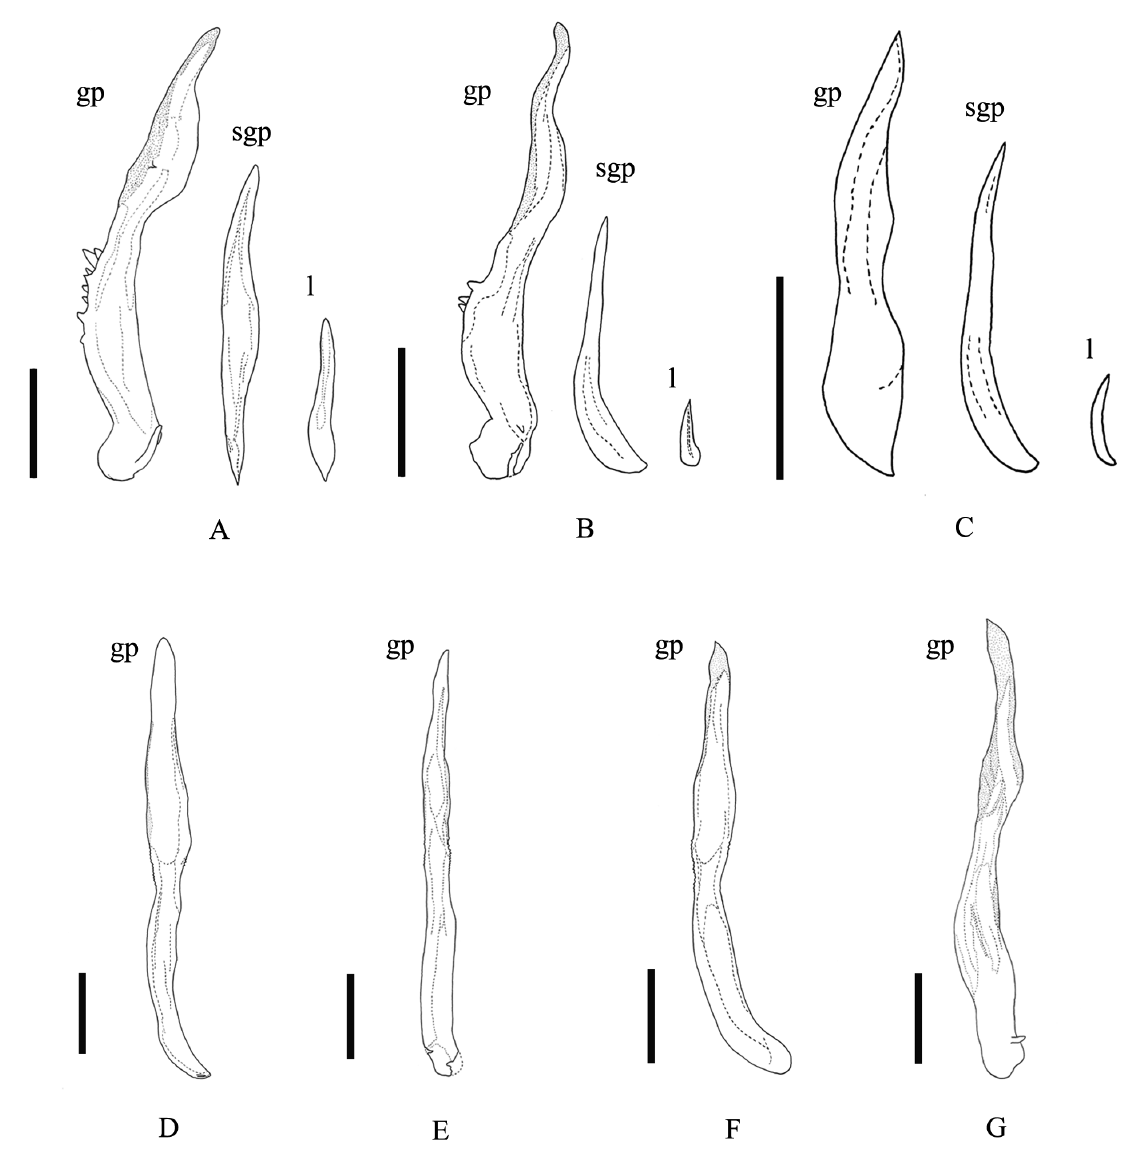
Fig. 10. Endophallic sclerites of Intybia spp. A . Intybia histrio (Kiesenwetter, 1874). B . I. tsushimensis (Satô & Ohbayashi, 1968). C . I. donan sp. nov. D . I. pelegrini pelegrini (Pic, 1910). E . I. niponica (Lewis, 1895). F . I. takaraensis (Nakane, 1955). G . I. kishiii (Nakane, 1955). Abbreviations: gp = gonoporal piece; l = ligula; sgp = semi-gonoporal piece. Scale bars = 0.1